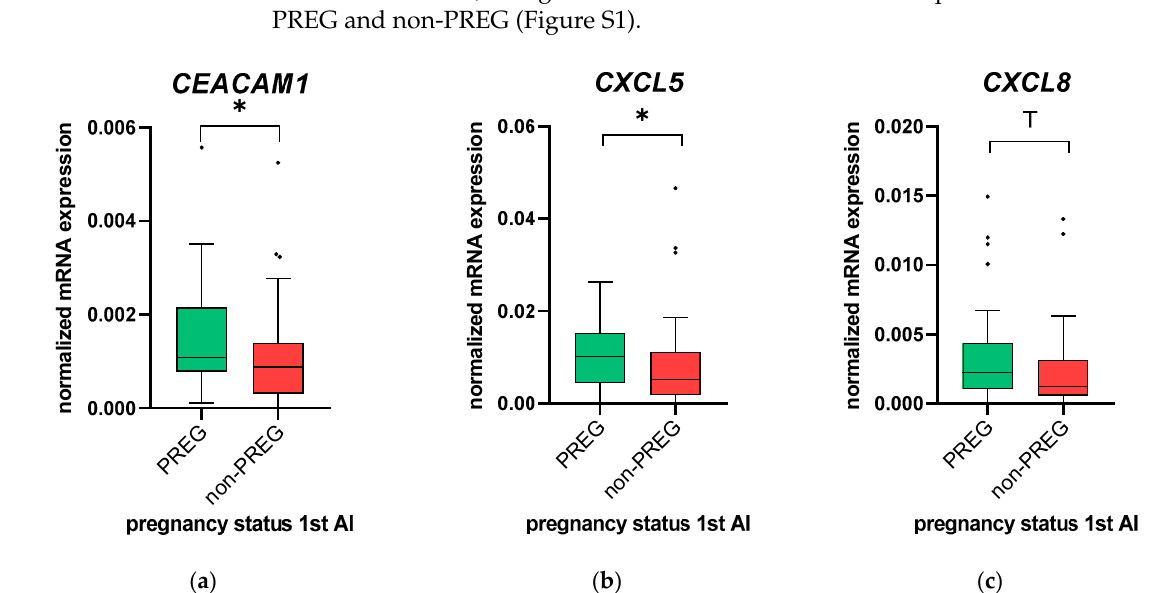
Figure 1. Normalized CEACAM1 ( a ), CXCL5 ( b ) and CXCL8 ( c ) mRNA expression in endometrial cytobrush samples collected from animals at the time of artificial insemination (AI). Animals were grouped by animals that conceived (PREG; n = 32) or did not conceive (non-PREG; n = 39) from the first insemination after calving. Values are represented as box-and-whisker plots with median values and 50% of the data within the boxes. Whiskers include all data points within 1.5 times the interquartile range (IQR). All outliers ( ≥ 1.5 times IQR) were included in the statistical analyses. Significant differences with p ≤ 0.05 between groups are indicated with an asterisk (*), and a trend towards statistical significance ( p = 0.051–0.1) is marked with a “T”.